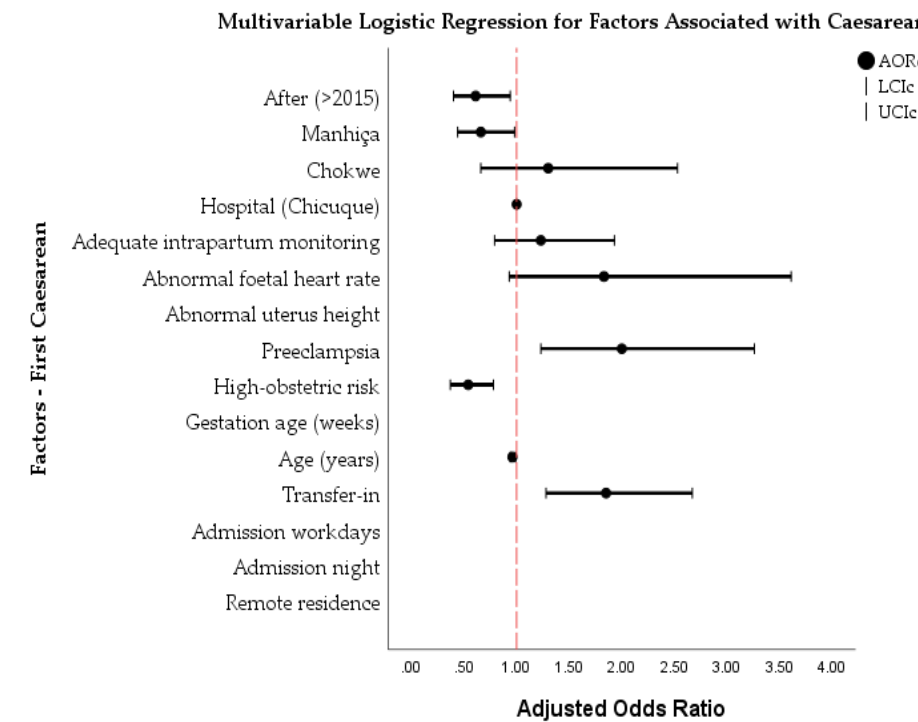
Figure A1. Factors Associated with First Caesarean; Figure A2: Factors Associated with Obstetric Complications; Figure A3: Factors Associated with Neonatal Complications.